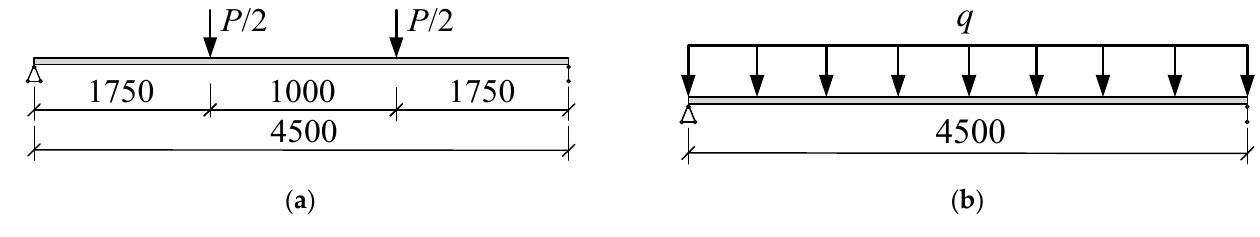
Figure 11. Loading conditions (unit: mm): ( a ) LC1; ( b ) LC2.